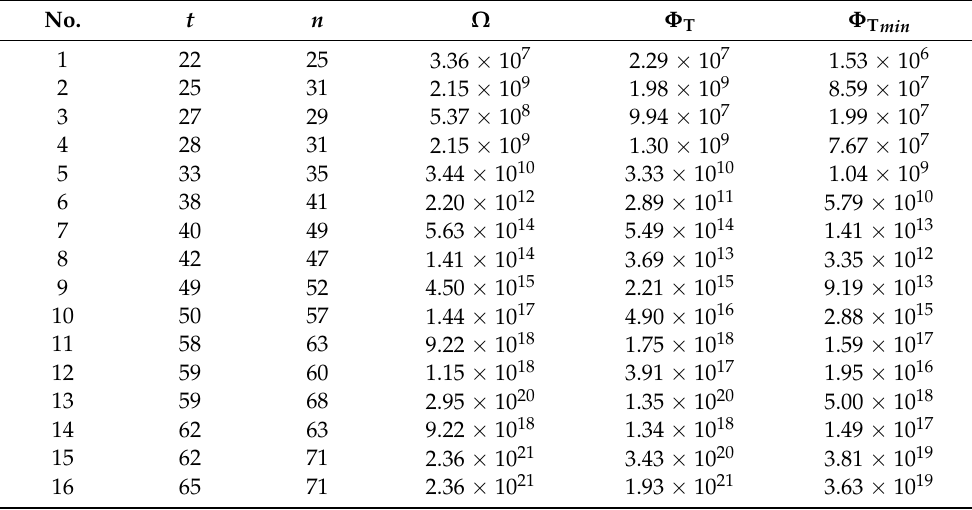
Table 1. Minimum phase shift at outputs of T-type flip-flops within the DT-LFSR register in question.